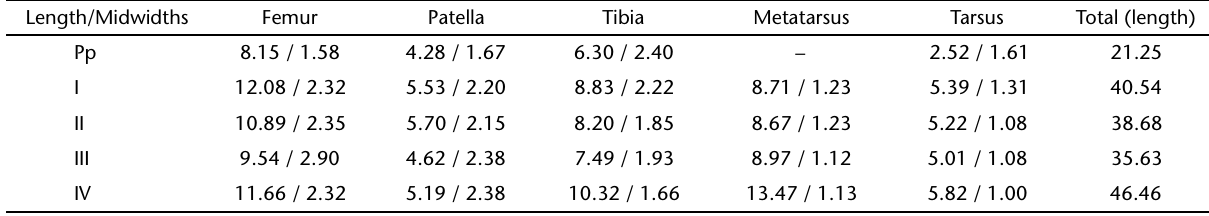
Table VII. Vitalius nondescriptus comb. nov. Male MZSP 465171 from Ouro Preto, state of Minas Gerais, Brazil (captive born from female MZSP 465351). Length and midwidths of right legs and palpal segments. Length/Midwidths